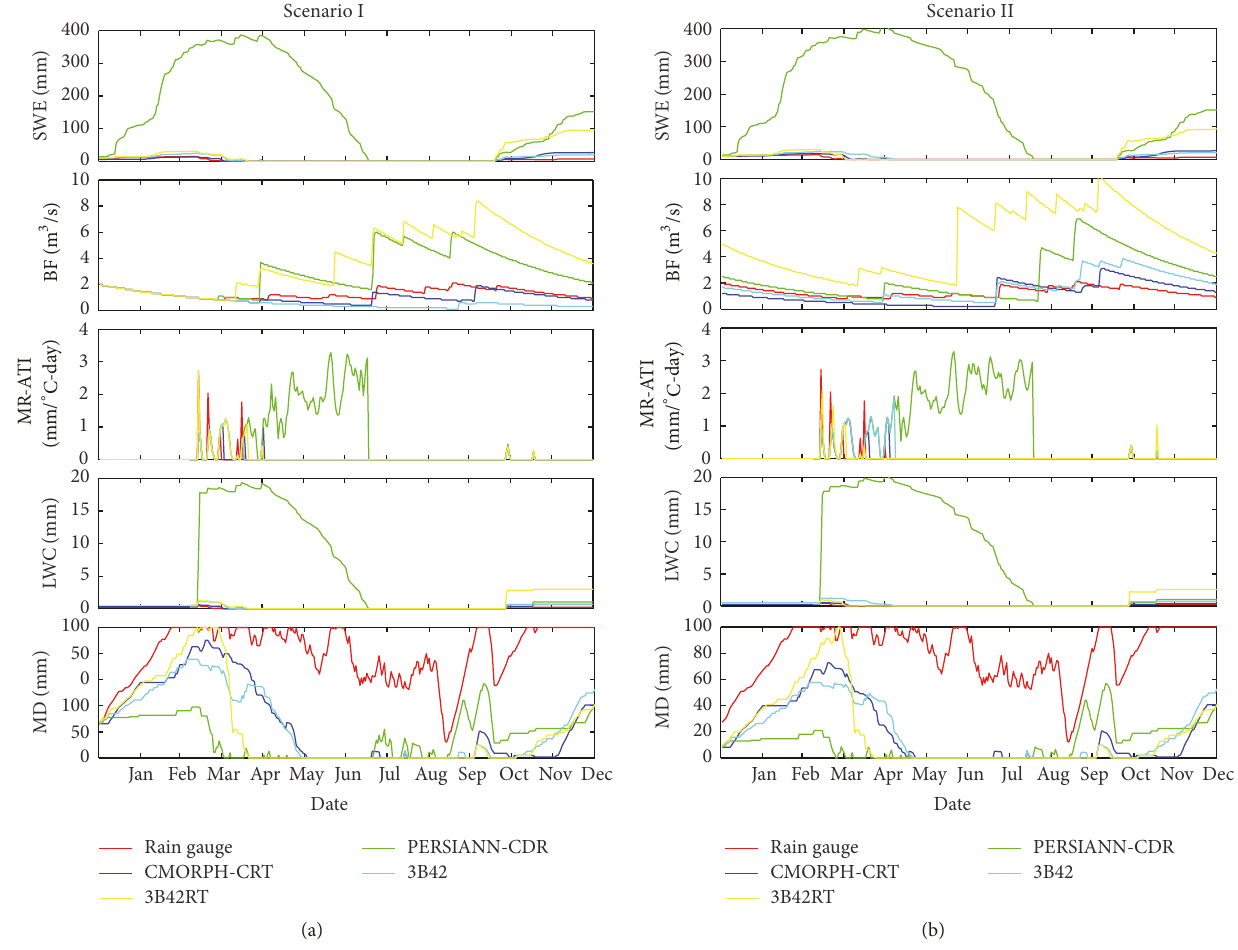
Figure 11: SWE, BF, MR-ATI, LWC, and MD derived by HEC-HMS model with the four-satellite and gauged precipitation data as forcing inputs under scenario I (a) and scenario II (b) in the dray year